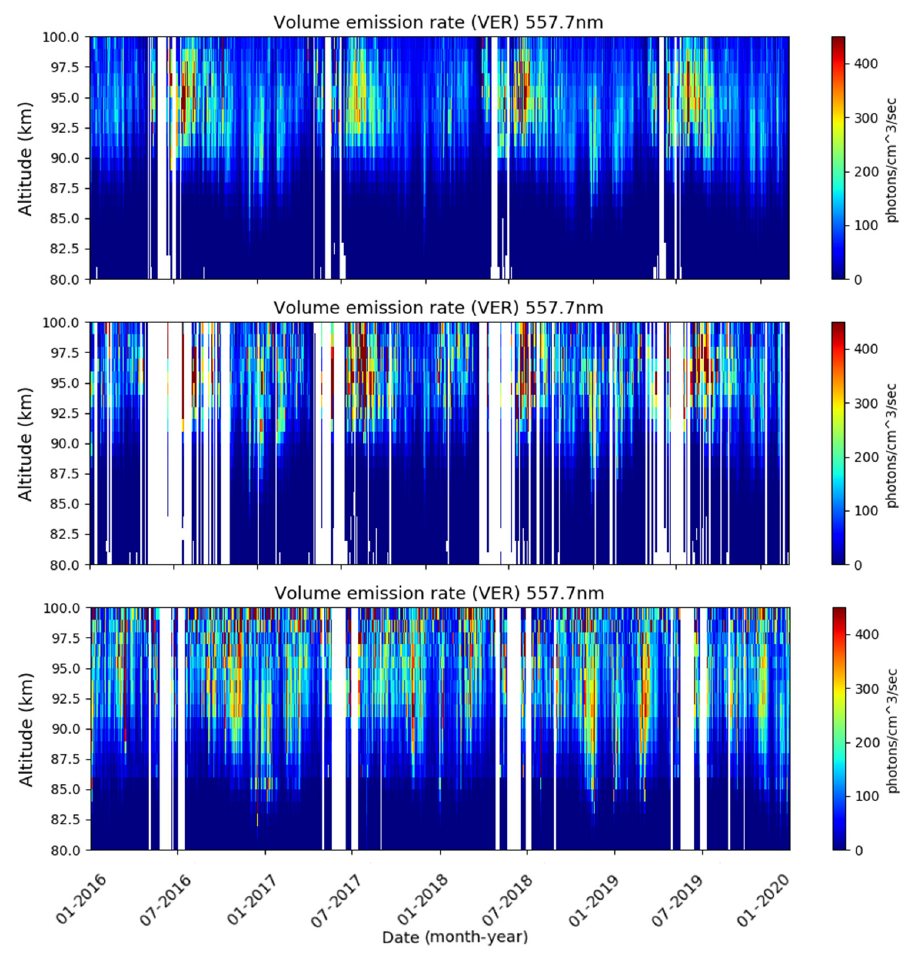
Figure 5. Dynamics of height profile of atomic oxygen concentration over 2016–2020 above GPO in Tory, nighttime. Top presents data calculated using [20]; middle presents data calculated using [24]; and bottom presents data obtained using dataset described in [25].